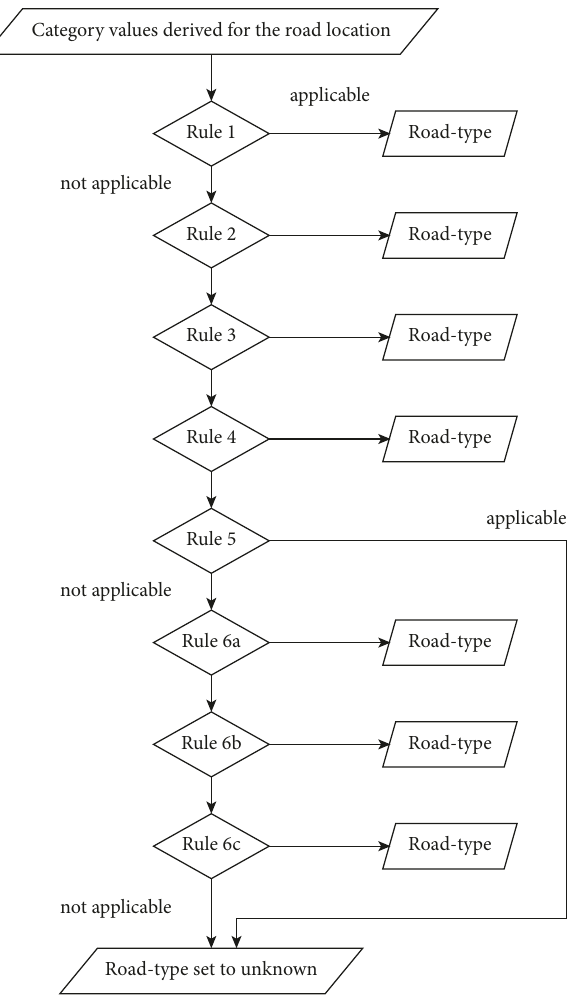
Figure 6: The sequential application of Rules 1–5, 6a, 6b, and 6c leading to the decision on the current road type. Note . Rule 7 is represented only as the “not applicable” branch of Rule